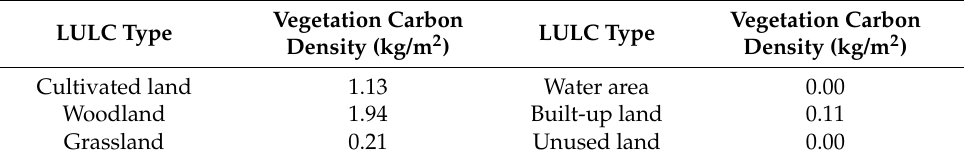
Table 2. The vegetation carbon densities of different land use/land cover (LULC) types in the Jiangsu Province.